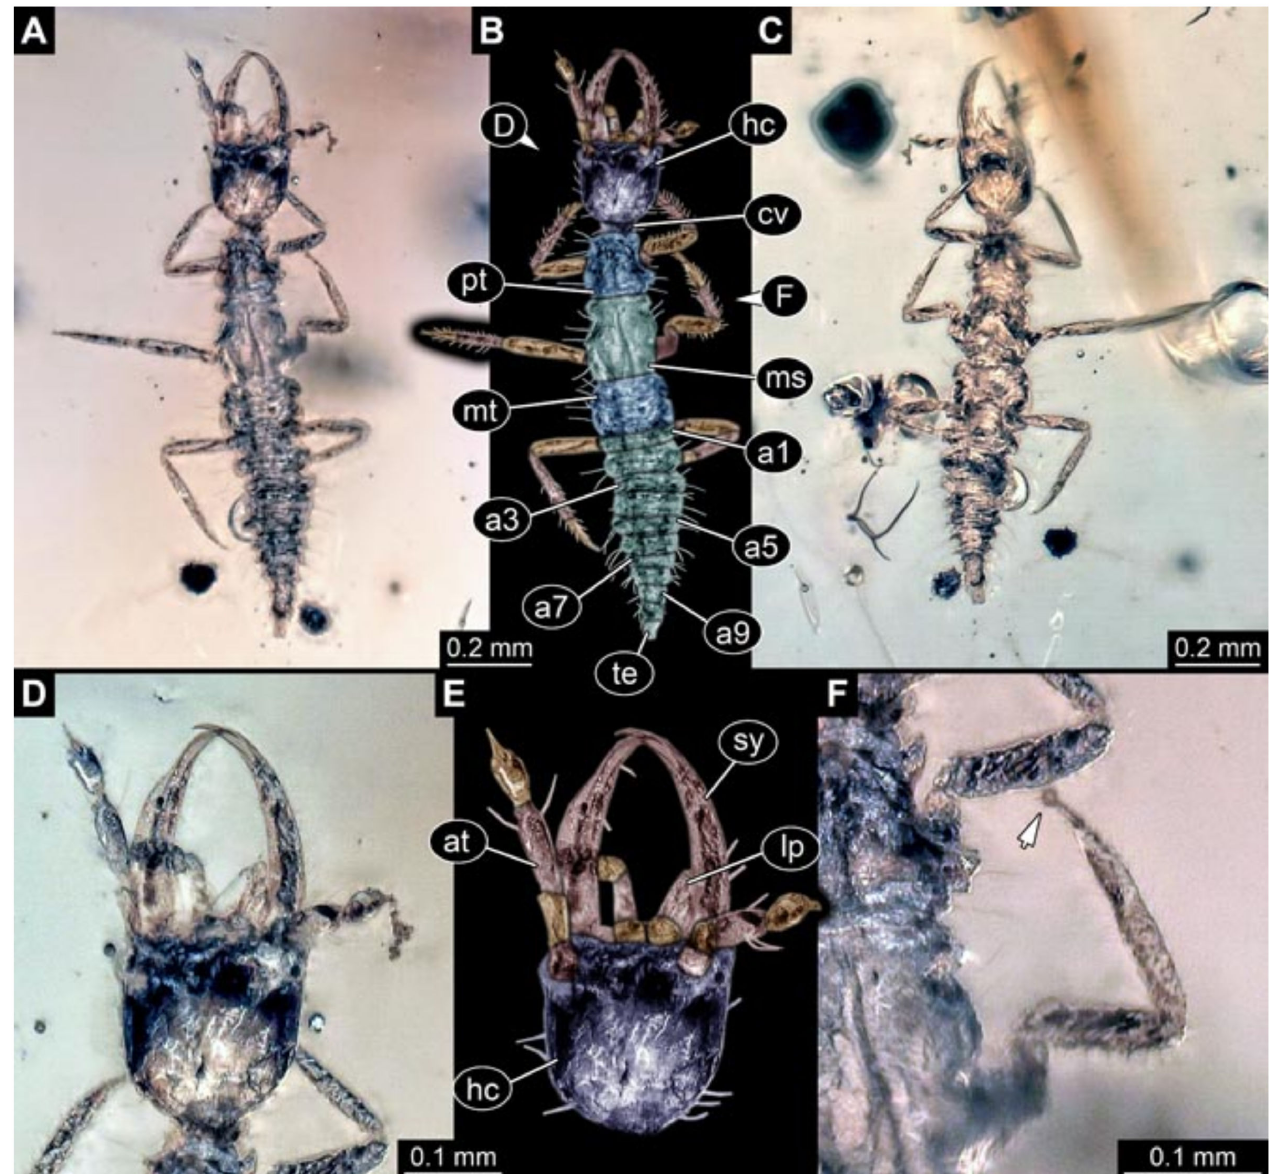
Figure 25. Specimen 5856 (PED 0899); Myanmar amber. ( A ) Dorsal view. ( B ) Dorsal view, colour-marked. ( C ) Ventral view. ( D ) Close-up of head in dorsal view. ( E ) Close-up of head in dorsal view, colour-marked. ( F ) Close-up of trunk appendages with empodia (arrows) in dorsal view. Abbreviations: a1–a9 = abdomen segments 1–9; at = antenna; cv = cervix; hc = head capsule; lp = labial palp; ms = mesothorax; mt = metathorax; pt = prothorax; sy = stylet; te = trunk